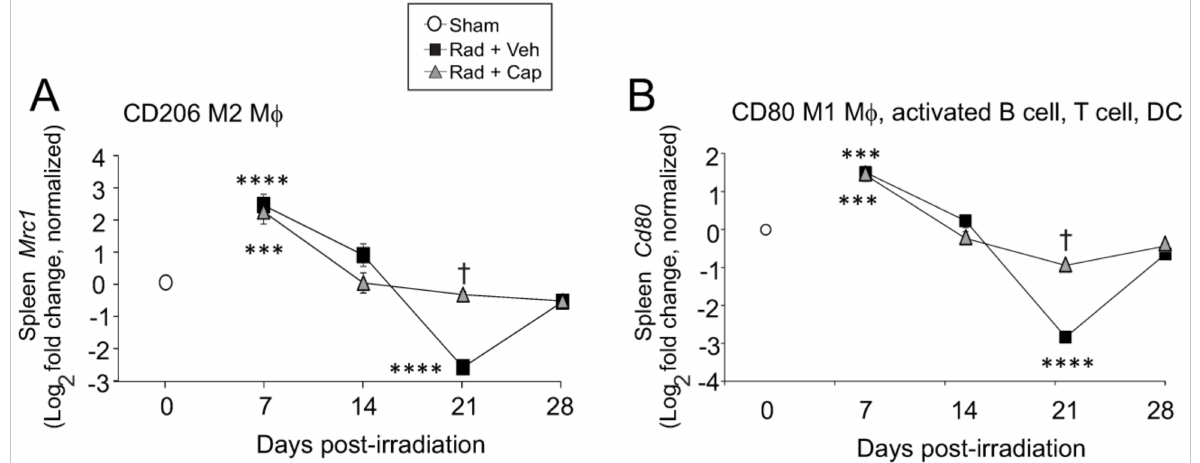
Figure 8. Total body irradiation results in altered gene expression for macrophage polarity mark- ers in the spleen. C57BL/6 mice were exposed to 6.85 Gy total body irradiation. Animals received vehicle (drinking water alone) or captopril in the drinking water on days +2–+16 post-irradiation. At the indicated time points, mice were euthanized, and spleen tissue was obtained for RNA analysis. qPCR was performed for the following genes: ( A ) CD206 (M2 macrophage [M Φ ]); ( B ) Cd80 (M1 macrophage [M Φ ], activated B cell, T cell and dendritic cell [DC]). Graphs show means ± SEM from n = 4 animals per group. Asterisks: *** indicates p < 0.001 from control (sham); and **** indicates p < 0.0001 from control. † indicates p < 0.05 in the captopril-treated group from the vehicle-treated group at the same time